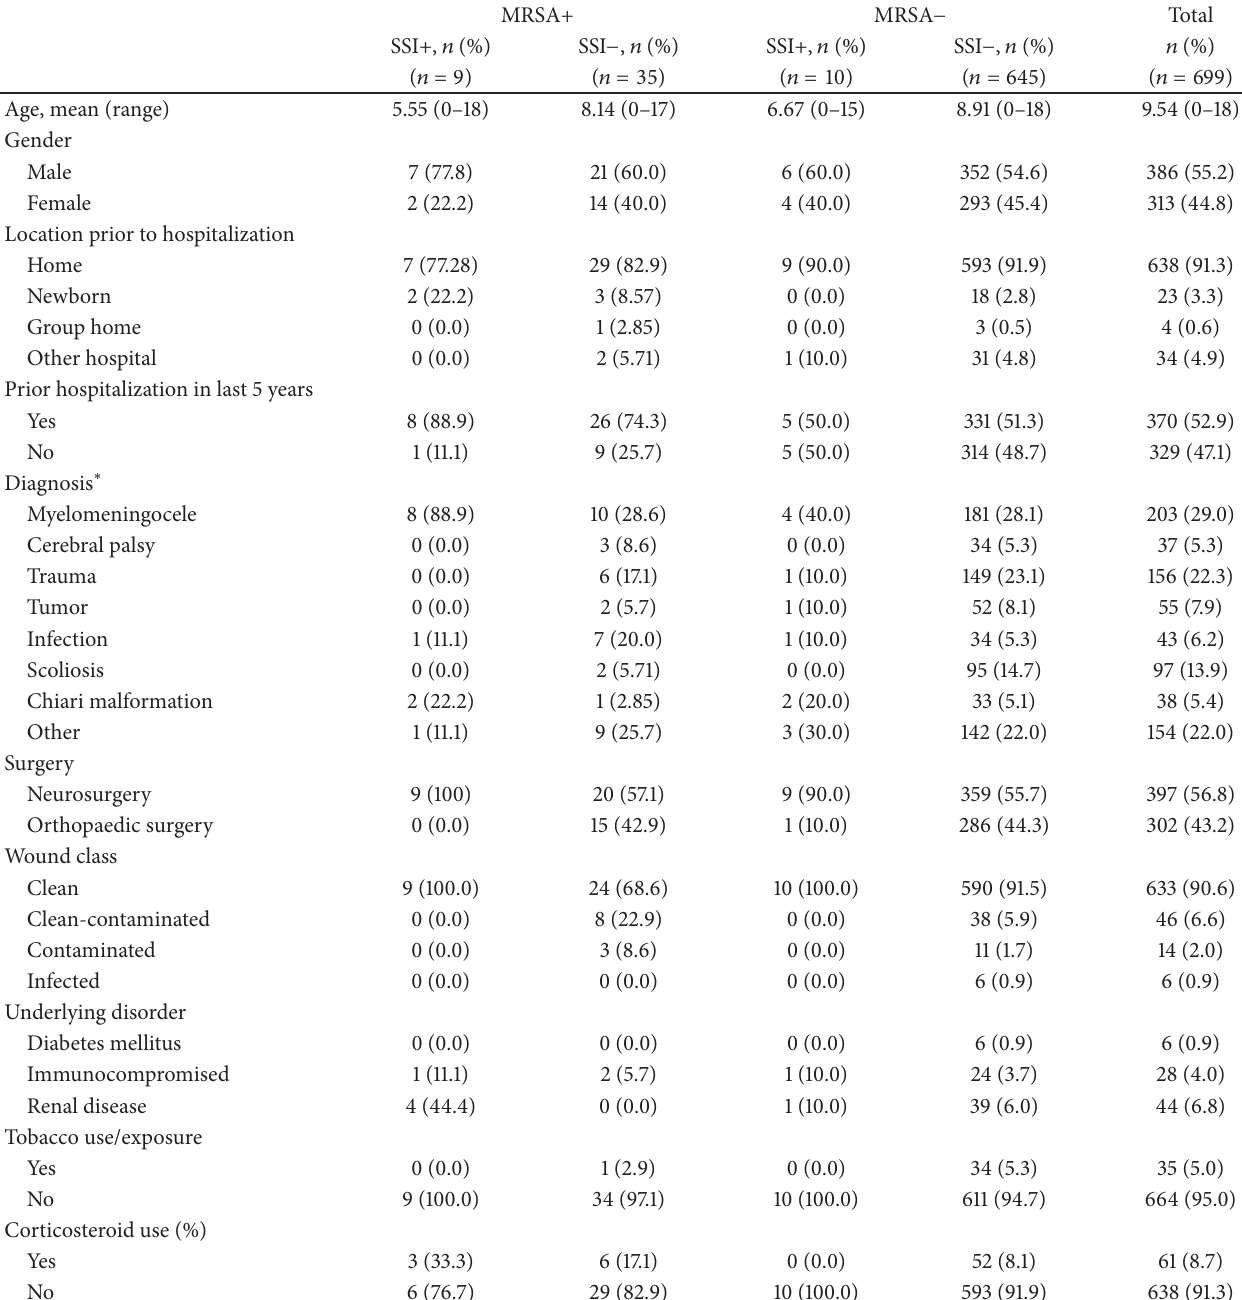
Table 1: Characteristics of the 699 patients included in the study with special emphasis on patients who tested MRSA positive on